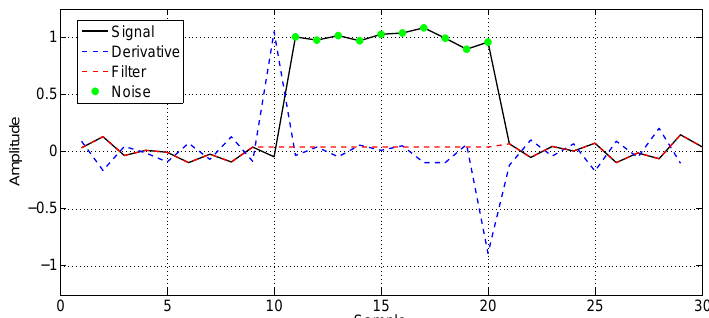
Figure 10. Heaviside noise filtering process. The acquired signal is depicted in black, the derivative in blue and the filtered signal in red.